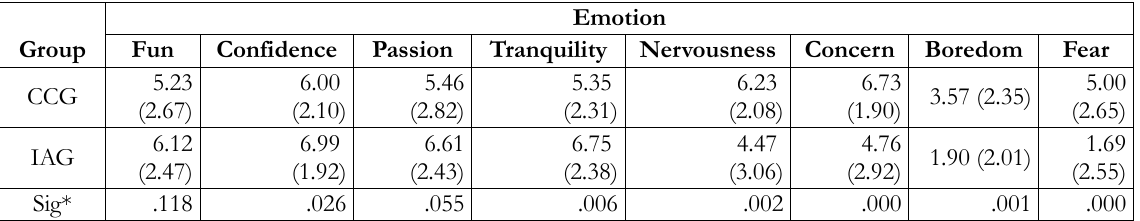
Table 2. Comparison of the mean scores (ranged from 0 to 10) given for each emotion